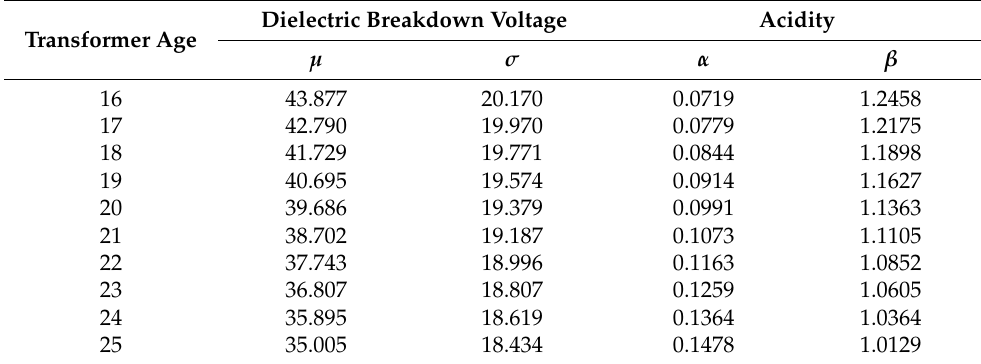
Table 3. Estimated distribution parameters for dielectric breakdown voltage and acidity.